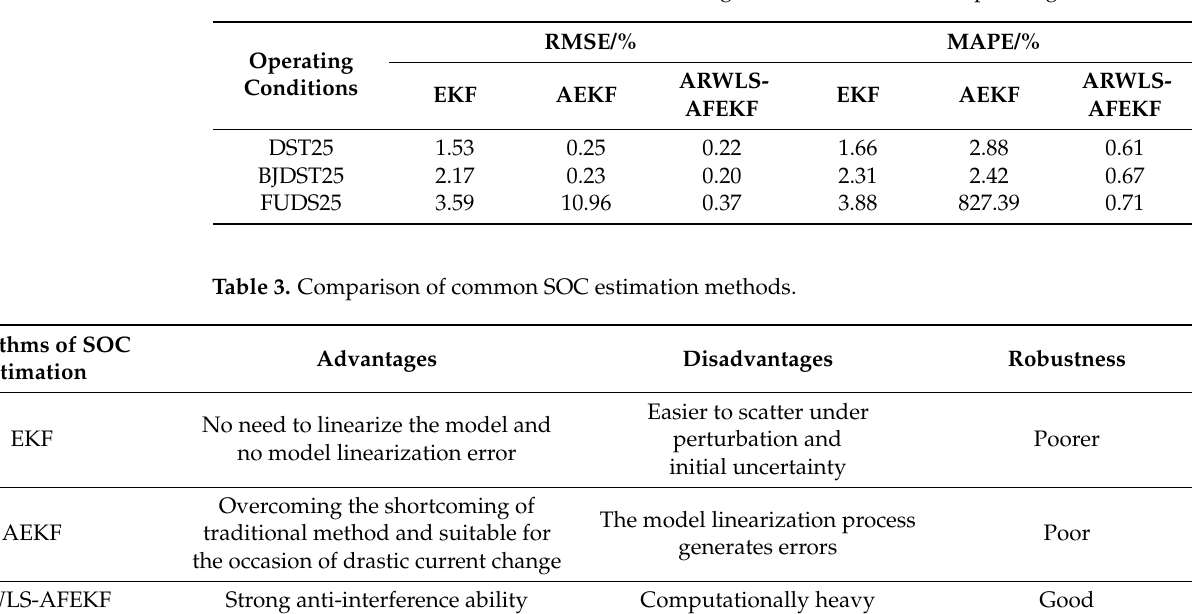
Table 2. RMSE value and MAPE value for fusion algorithm under different operating conditions.